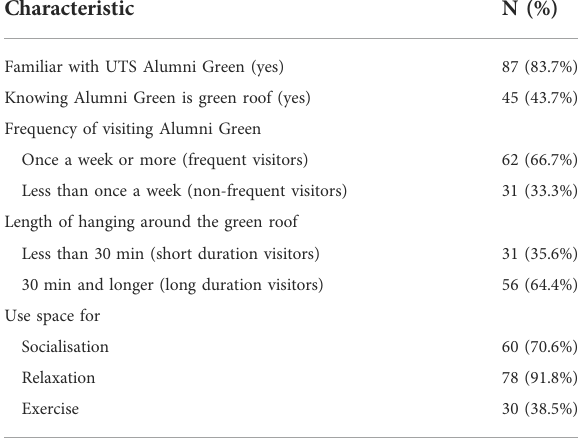
FIGURE 3 Regression model for RQ2.